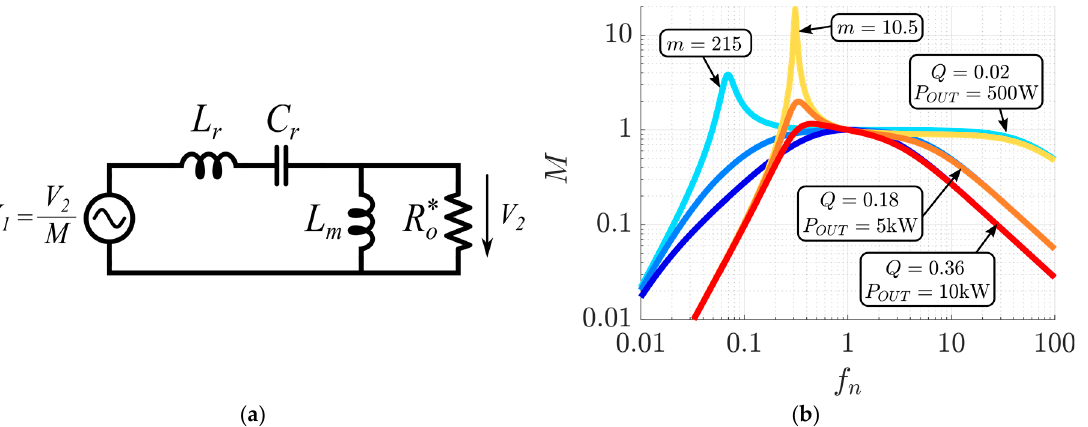
Figure 3. ( a ) LLC equivalent circuit (simplified first harmonic approximation (FHA)), ( b ) LLC voltage gain ( M ) at di ff erent inductance ratios ( m ) and quality factors ( Q ).